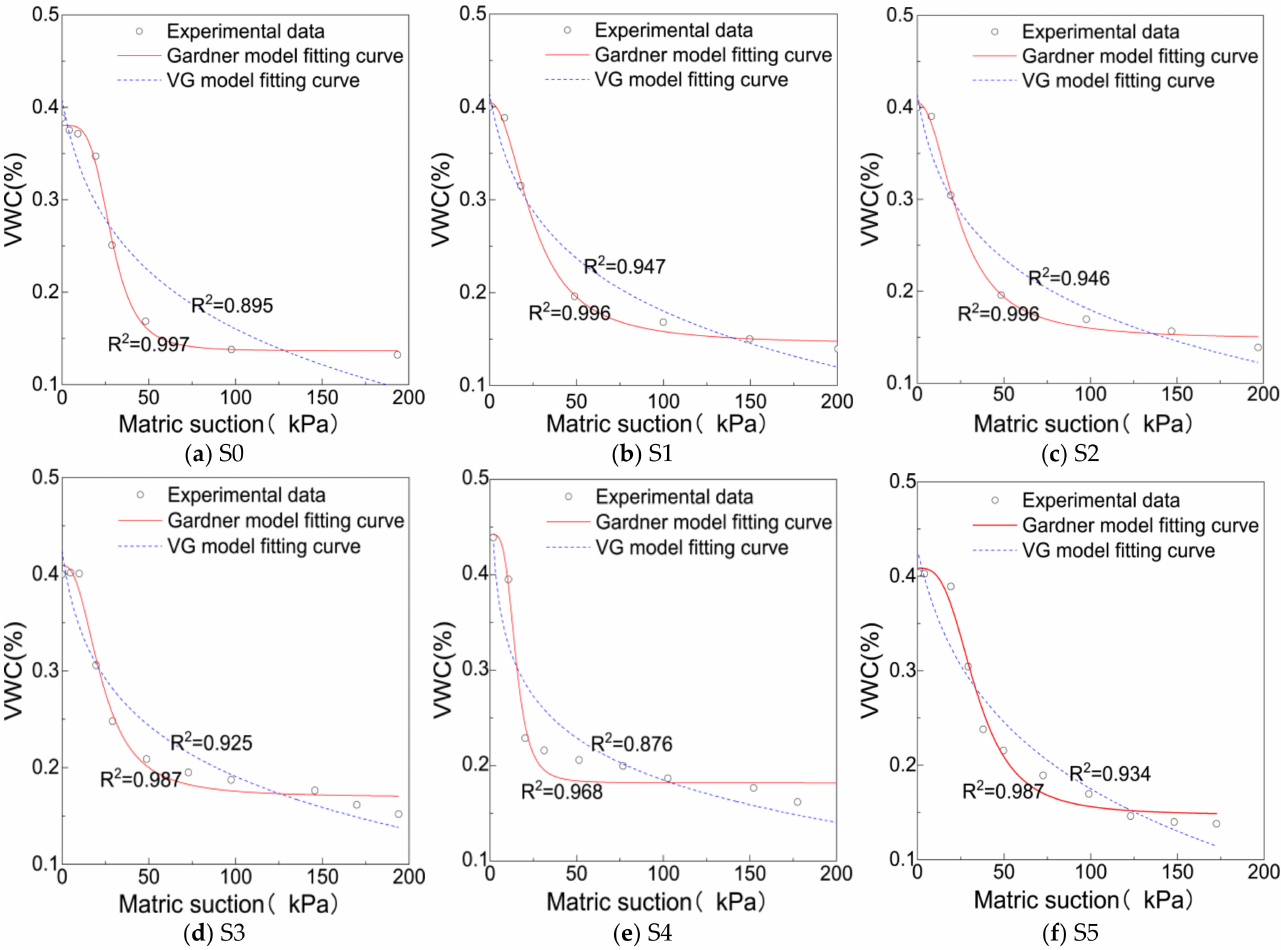
Figure 11. Experimental data and simulated SWCC of loess samples with different particle size